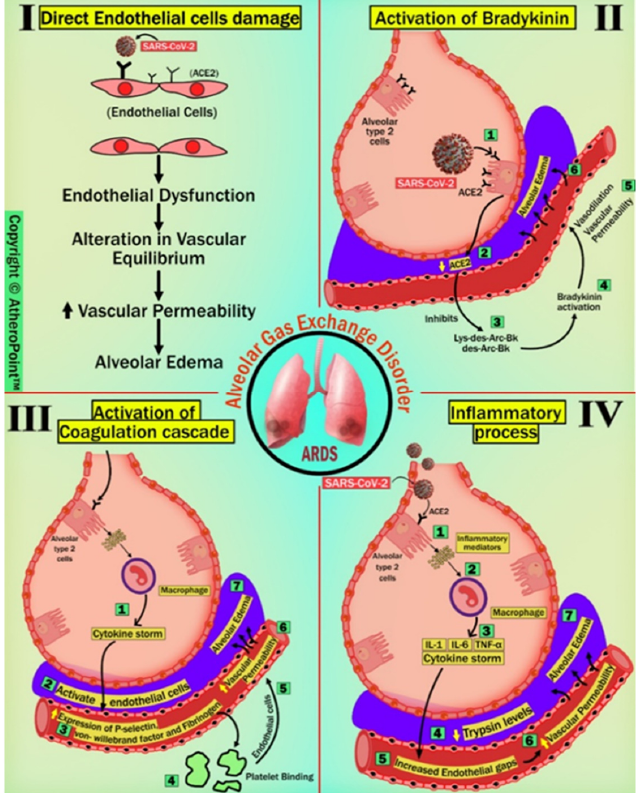
Figure 3. Detailed pathways of endothelial cell (EC) damage after COVID-19 infection contributing to the initiation of ARDS development. (Original image, AtheroPoint™ LLC, Roseville, CA, USA).